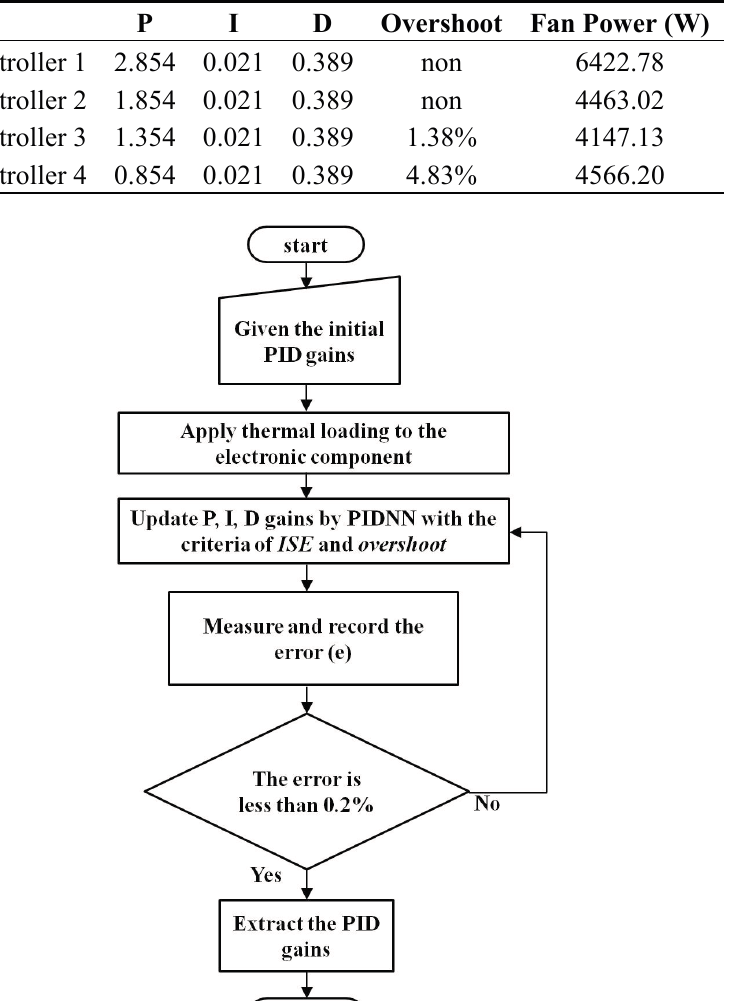
Figure 6. The flow chart of PID self-tuning.